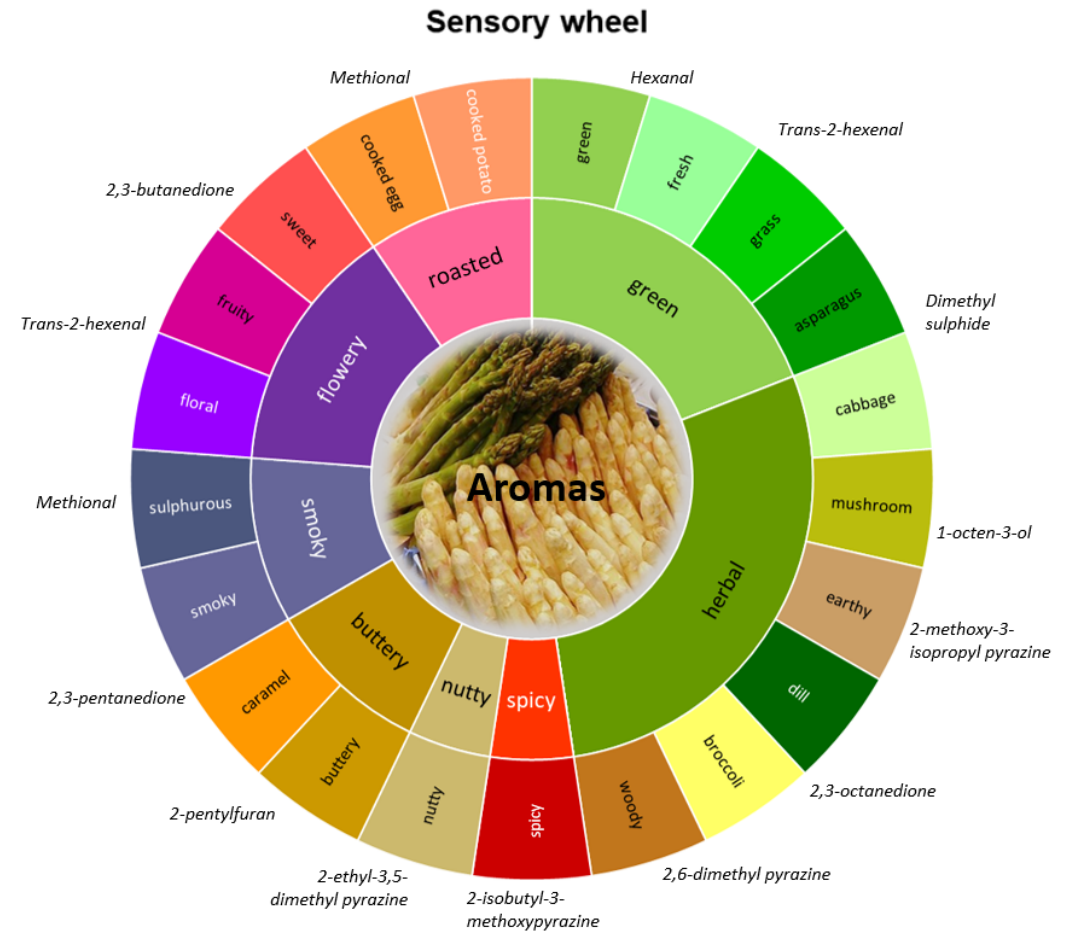
Figure 4. The Asparagus Sensory Wheel - constructed based on key odorants and sensory attributes from the literature reported in this review. The key odorants from Table 2 are included next to the main aroma attribute of their contribution for the typical asparagus odour. The key to a pleasant aroma profile is the right balance of all the aroma attributes and therefore, concentrations of the key